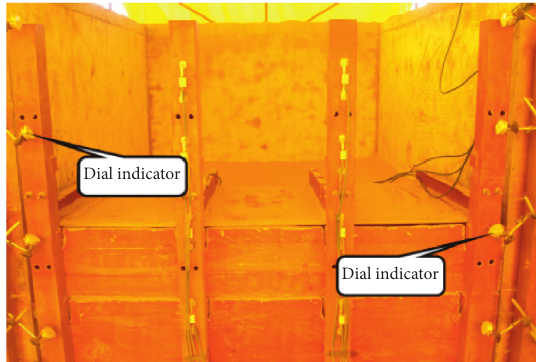
Figure 5: The layout of displacement measurement points of the retaining wall (unit: mm).